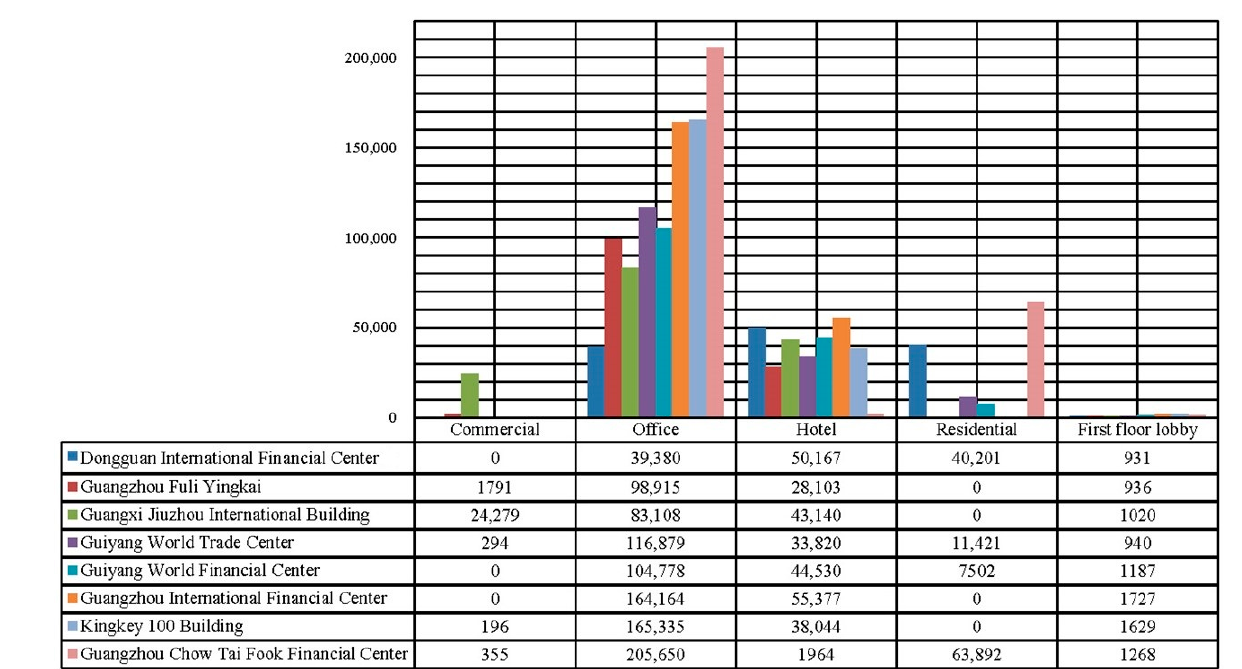
Figure 22. Statistics of the area of different business types (in m 2 ).